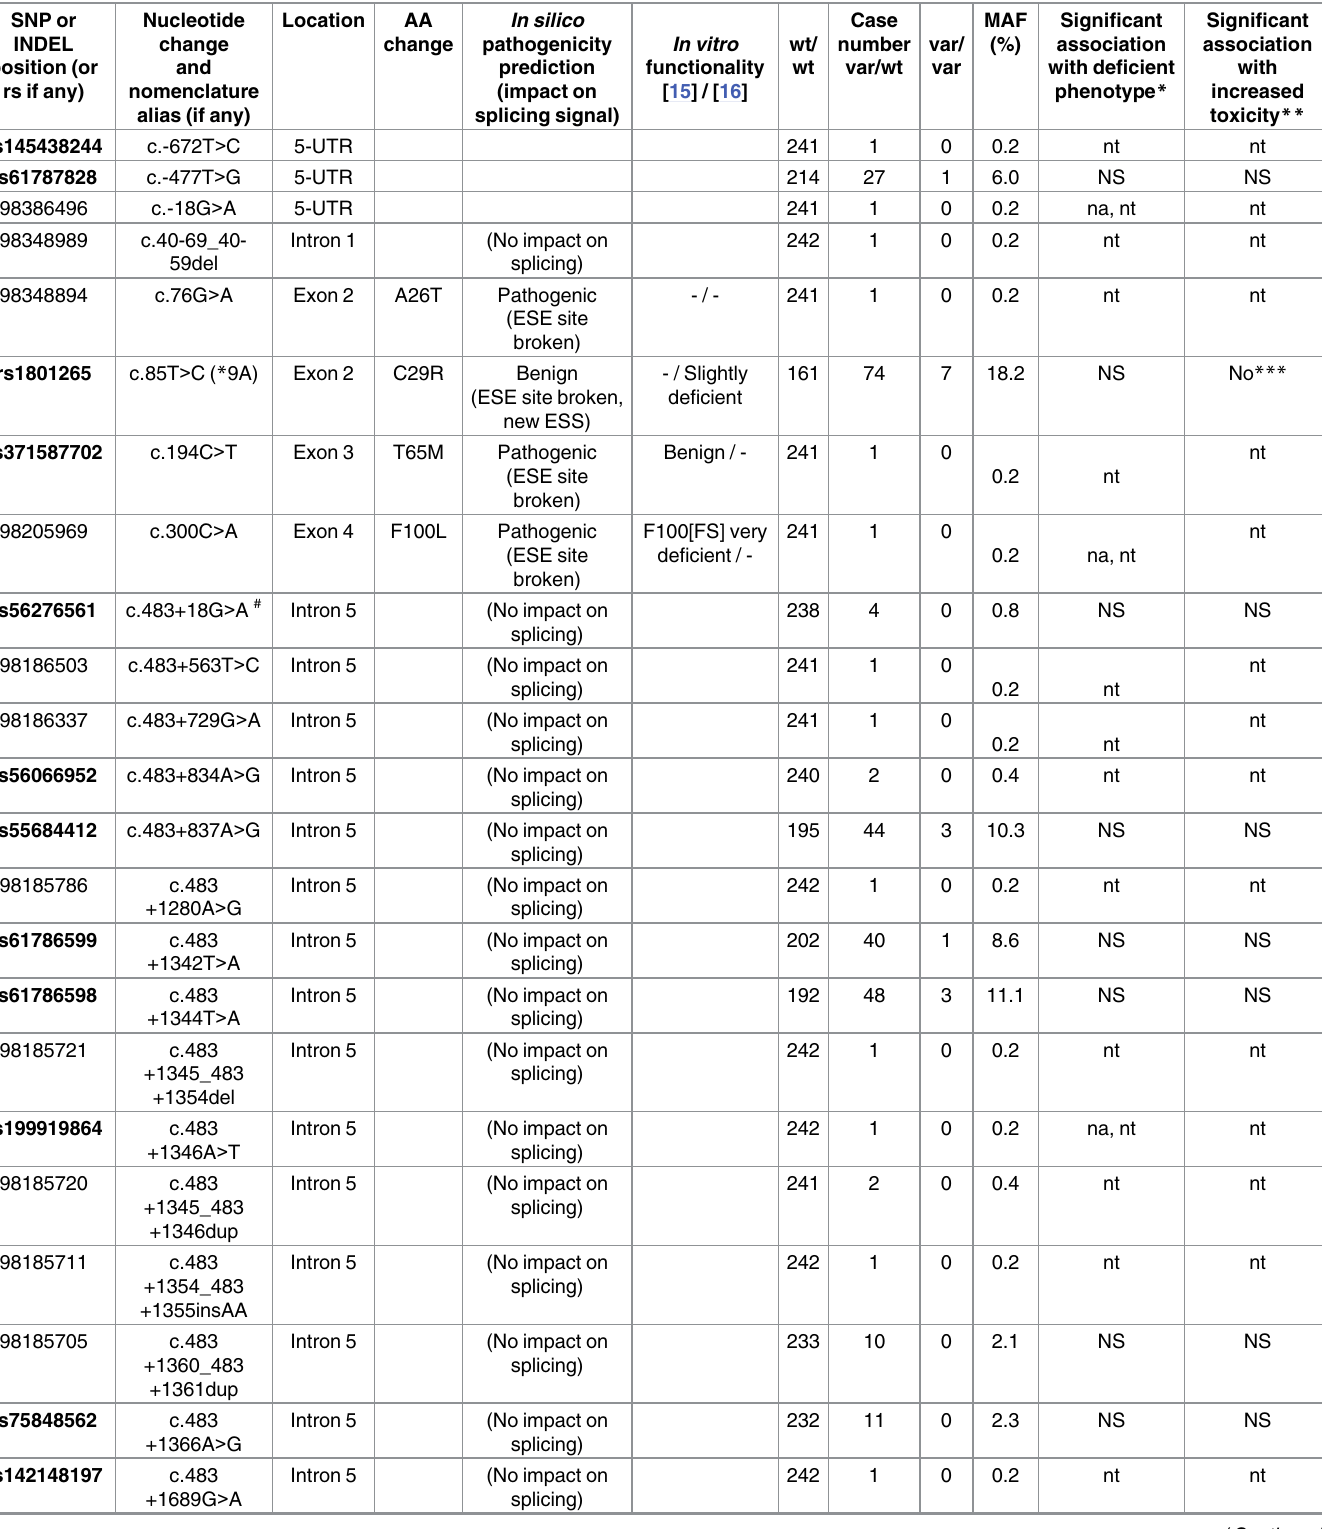
Table 3. Description of DPYD variations along with in silico / in vitro functionality. SNP or